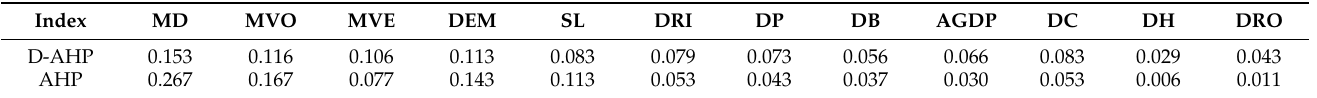
Table 5. Index weights calculated by the D-AHP, AHP, and entropy-weighting methods.